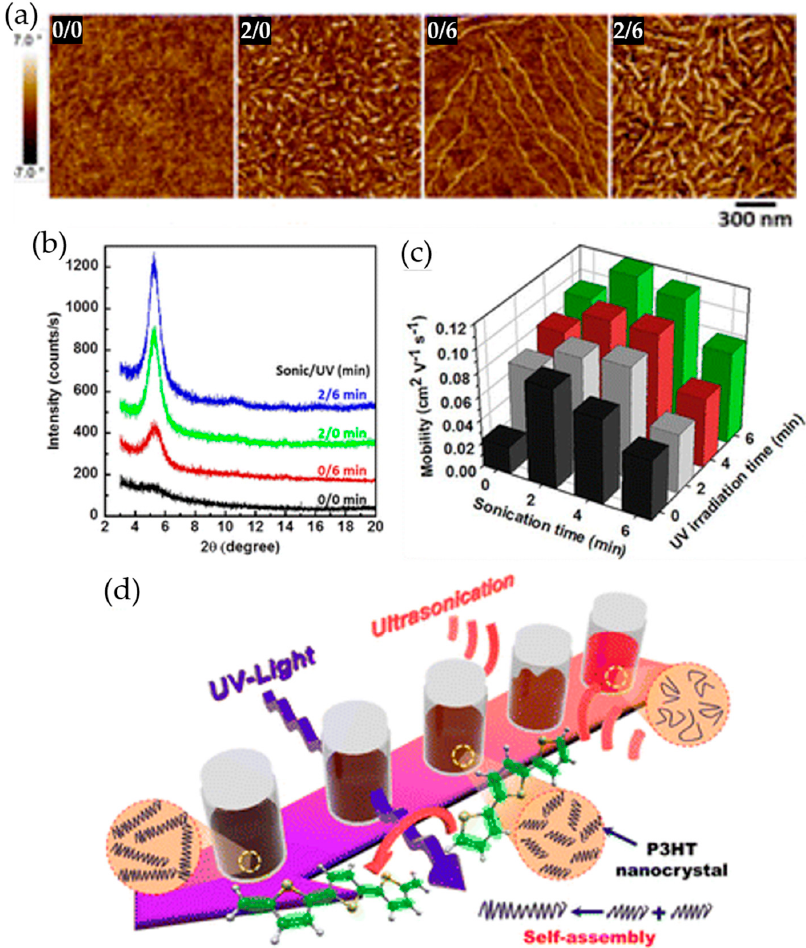
Figure 7. ( a ) Tapping mode AFM phase images of P3HT films spin coated from the polymer solutions treated by ultrasonication and subsequent UV irradiation for 0 and 0 min, 2 and 0 min, 0 and 6 min, and 2 and 6 min, respectively; ( b ) grazing incidence X-ray diffraction profiles of corresponding films; ( c ) average field-effect mobilities of P3HT films obtained by spin coating the polymer solutions exposed to ultrasonication and/or UV irradiation for various times; and ( d ) the Suggested mechanism describing the anisotropic assembly of P3HT nanocrystallites formed by ultrasonication into longer nanofibrillar structures via subsequent UV irradiation of the solution. Reproduced with permission from